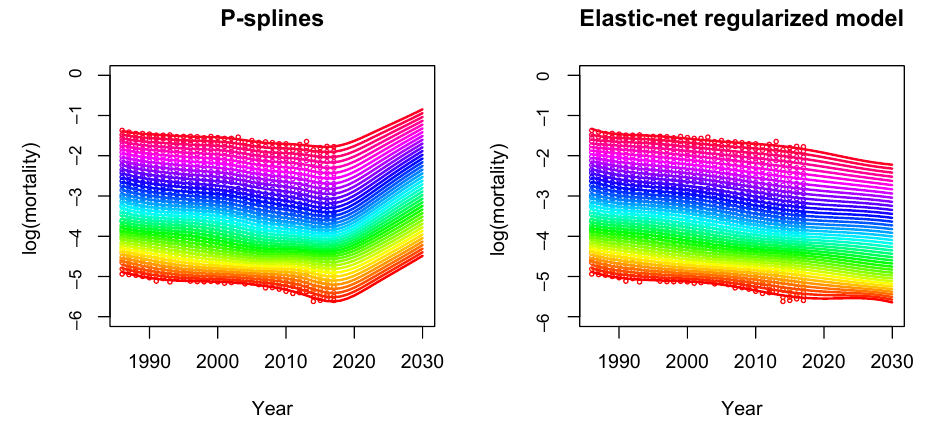
Figure 6. Logarithm of the fitted death rates and forecast death rates for France by ages (50–90) over years (1986–2030), after a pandemic shock in 2013 compensated by two years with lower mortality. On the left : forecast by the P-spline model. On the right : forecast by our regularized elastic-net model.